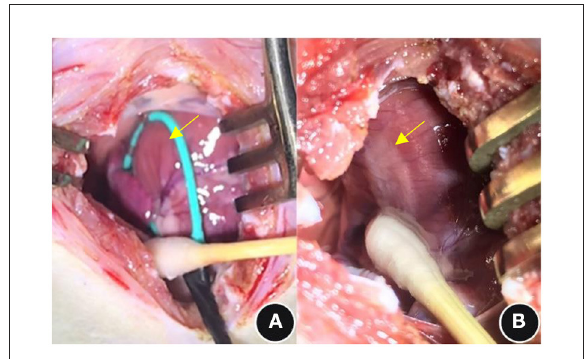
FIGURE2 General observations before and immediately after PEF ablation. (A) Pre-ablation and (B) post-ablation; see the yellow arrows. PEF, Pulsed electric